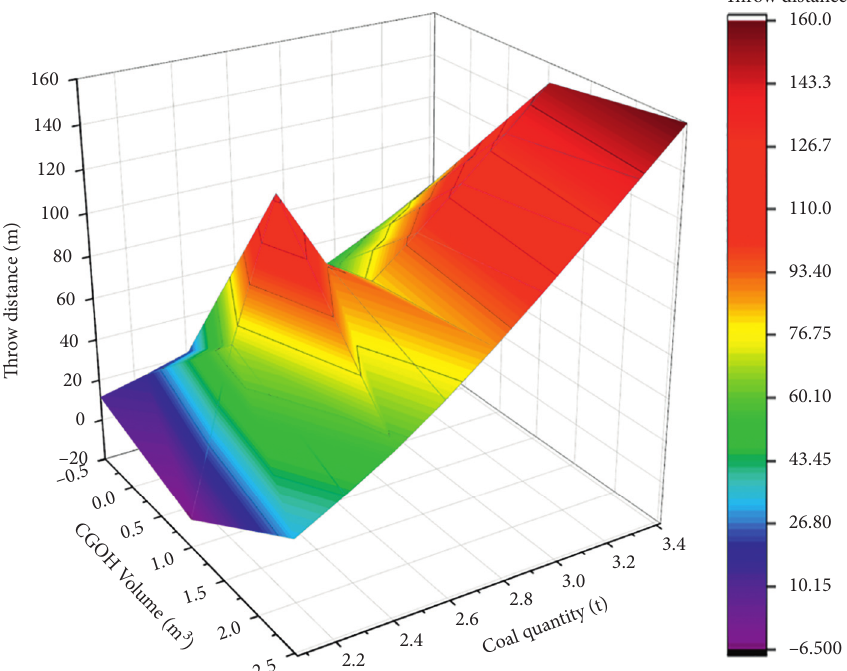
Figure 22: 3D color surface map of CGOH parameters ( XYZ log